Question: What visual encoding does this figure use to show its data?
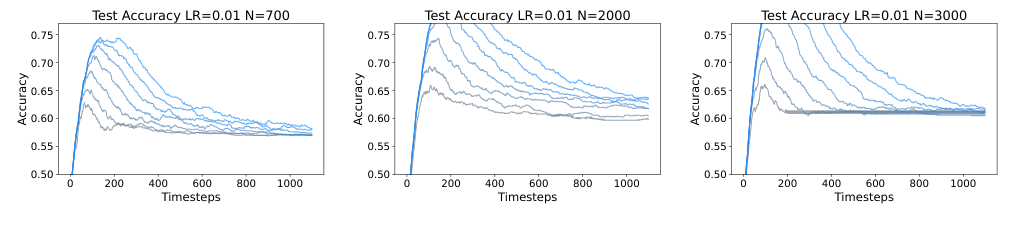
Answer: line